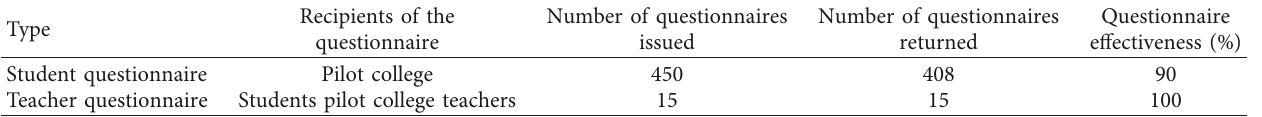
Table 1: Questionnaire statistical